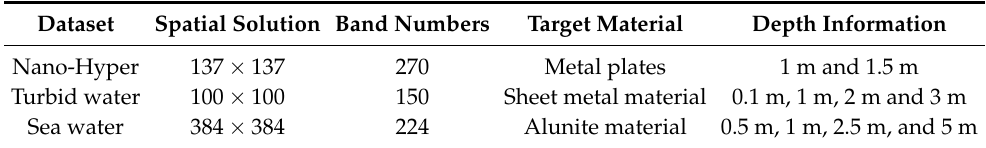
Table 1. The summary of the important information for all the experimental